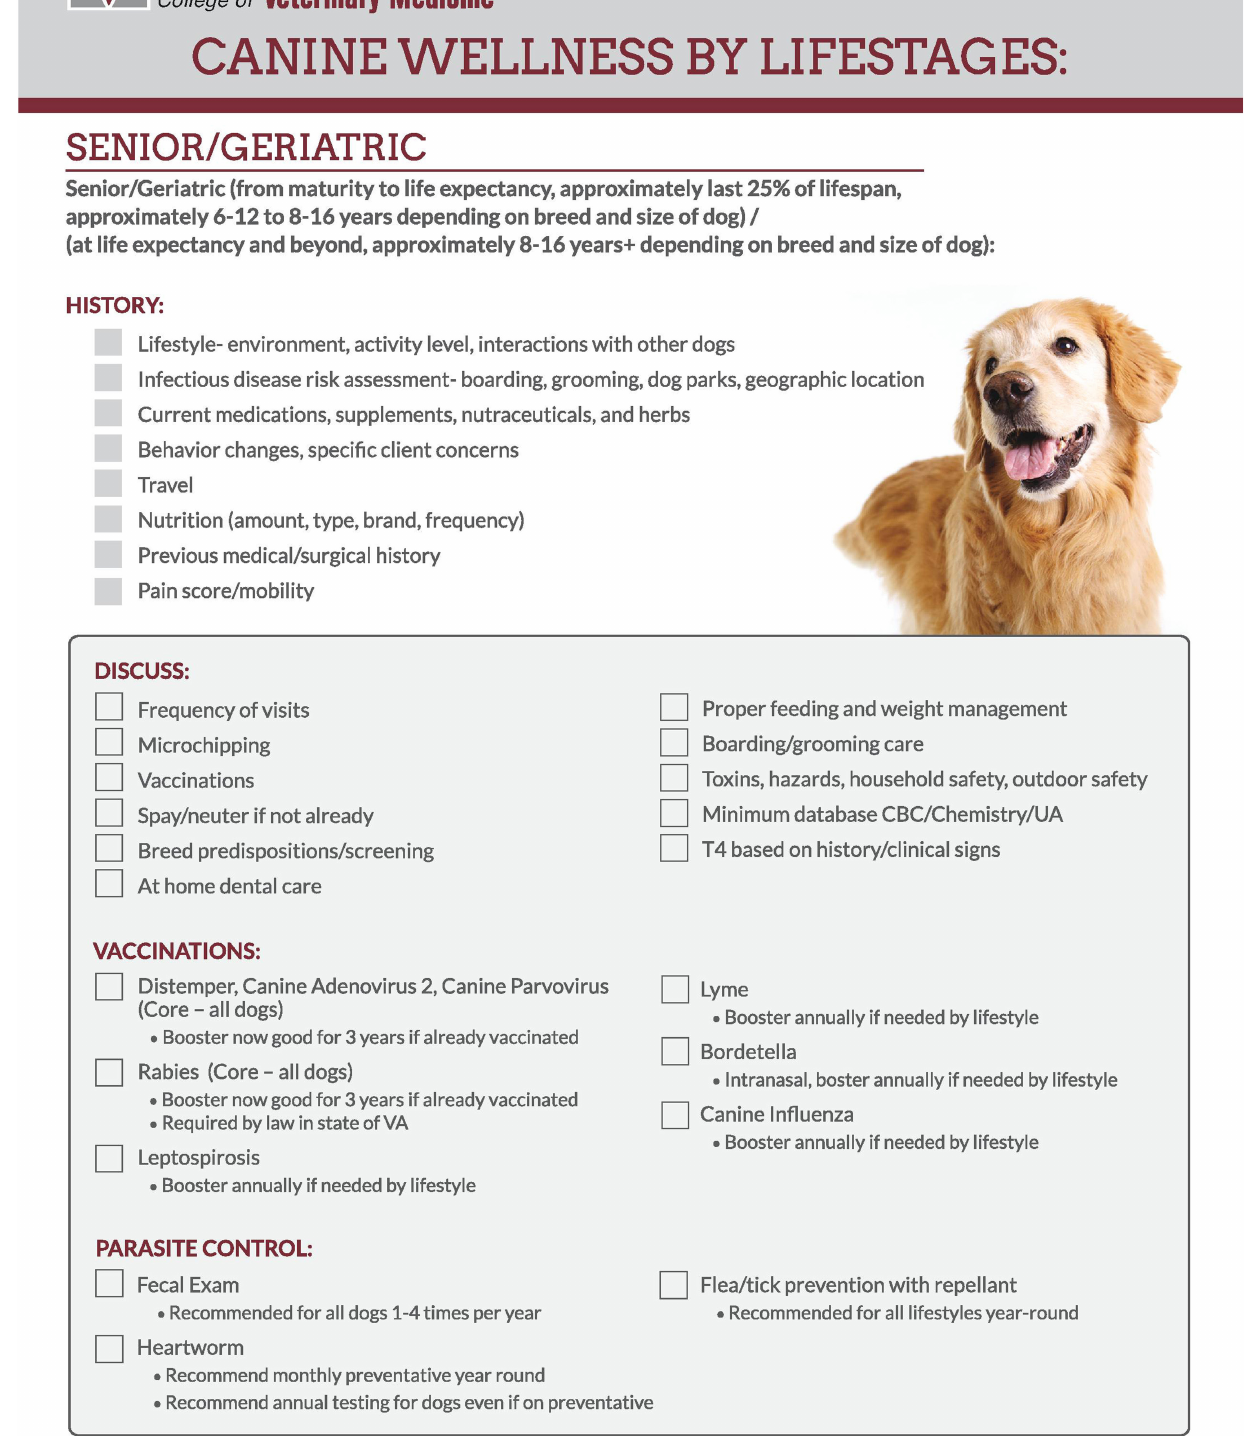
FigUre 2 | Example of modified checklist for senior dogs for Virginia-Maryland College of Veterinary